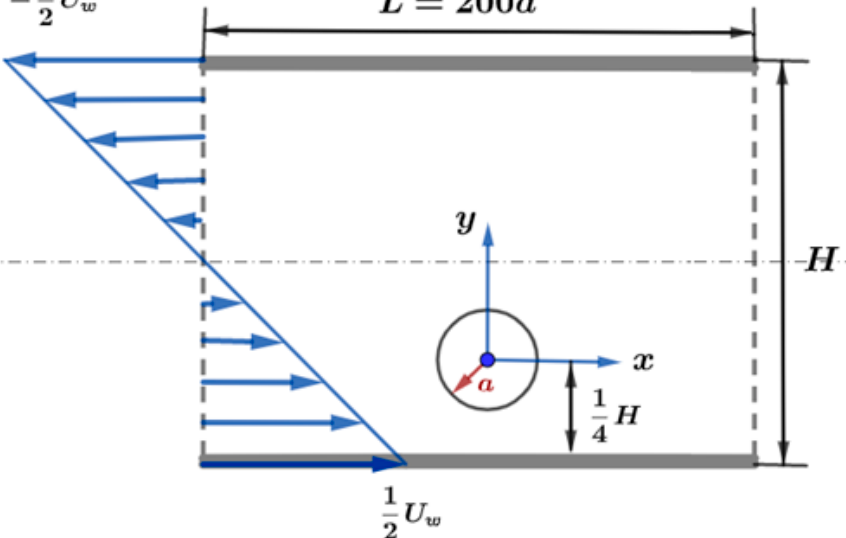
Figure 3. A particle in a shear flow.